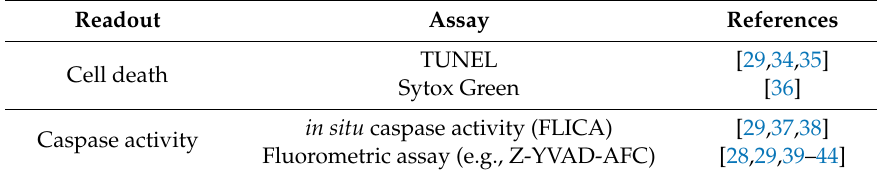
Table 1. General assays available for inflammasome research in